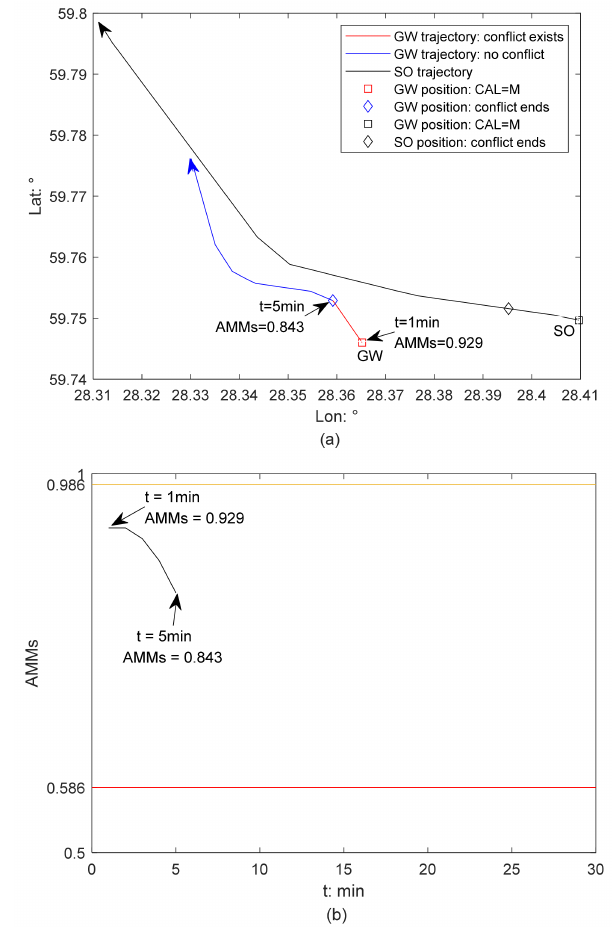
Figure 8. Illustration of the activation of AMM-based CAS from GW perspective in Scenario 2, with ship stability considered: ( a ) collision alert level determination; ( b ) the change of AMM of a